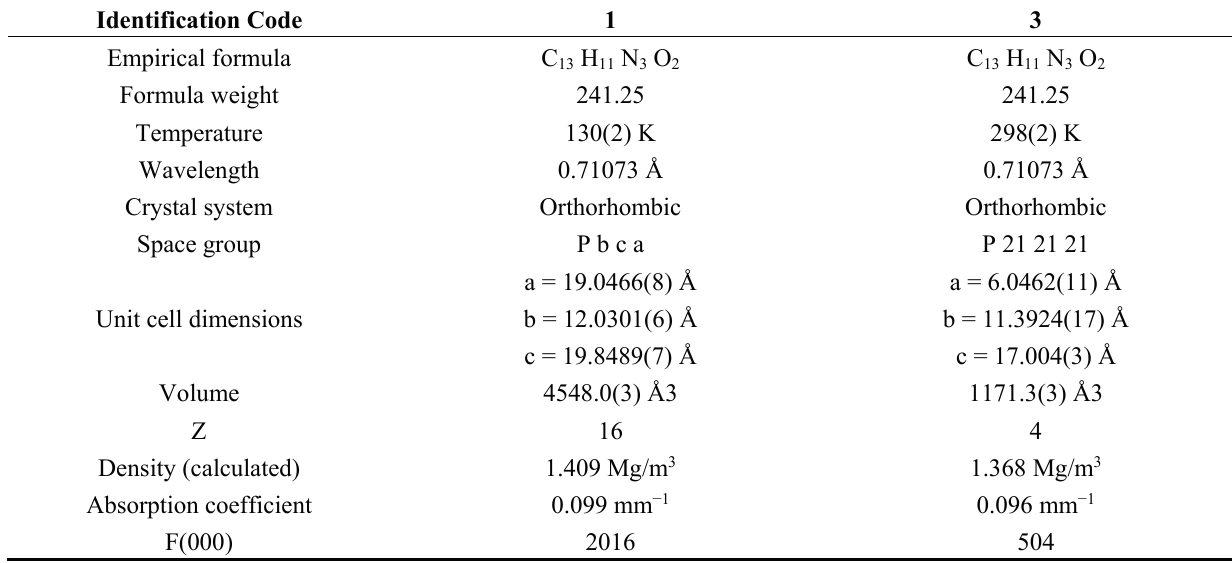
Table 4. Crystal data and structure refinement for 1 and 3